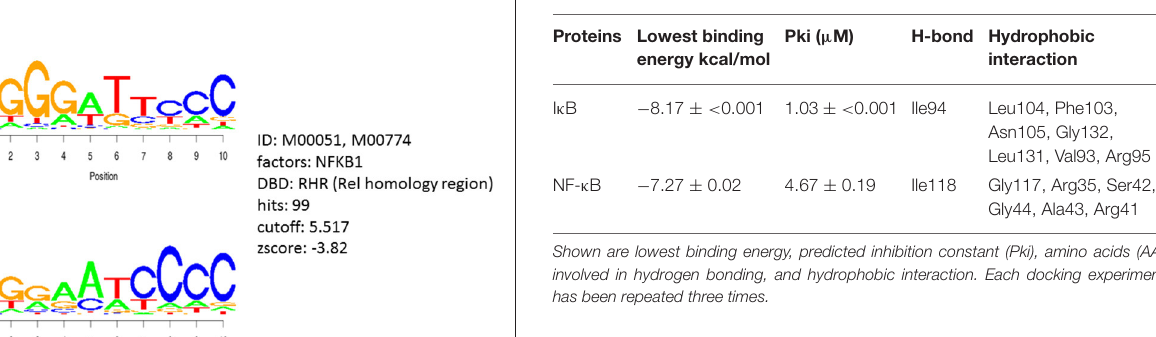
above did not confer resistance to sanguinarine indicating